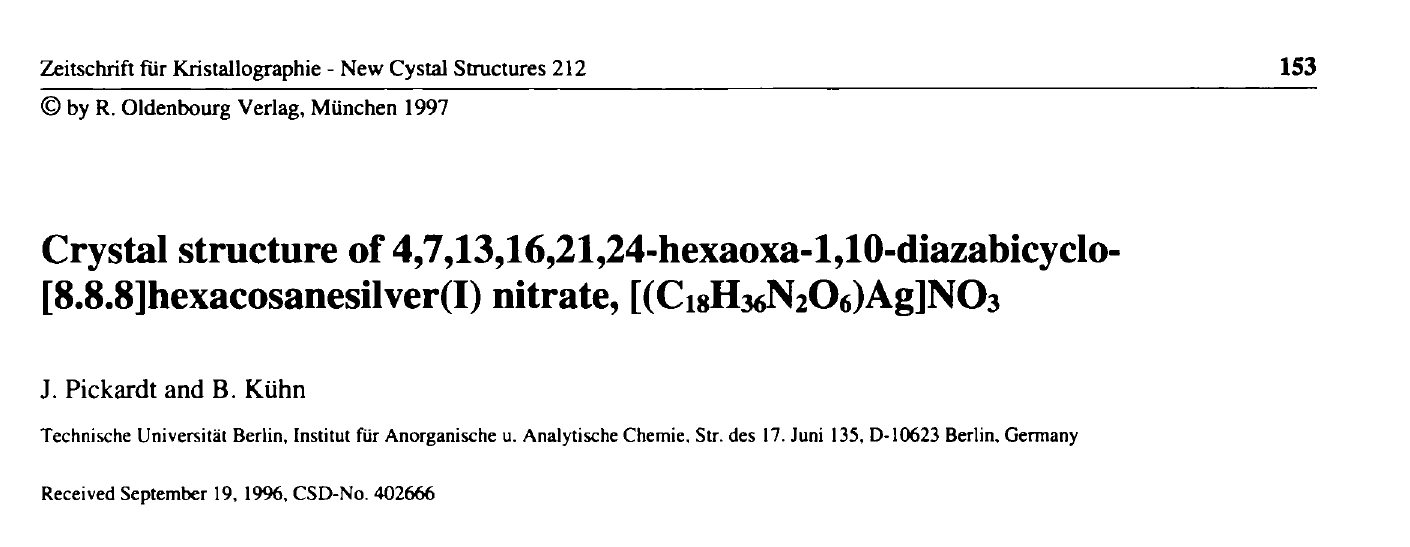
Table 1. Parameters used for the X-ray data collection Crystal: